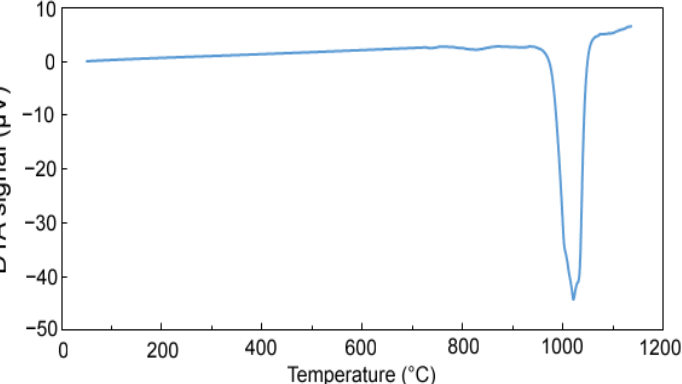
Figure 5. DTA heating curve of sample with 100% excess of aluminum over stoichiometry in the reduced state.